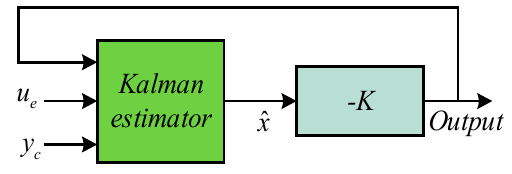
Figure 24. Structure of an LQG controller.